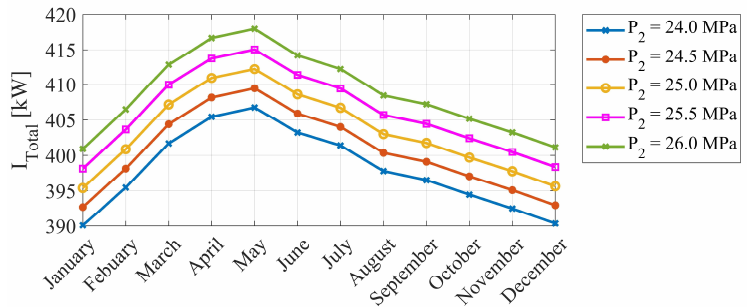
Figure 8. Total exergy destruction at different compressor outlet pressures (P 2 ).